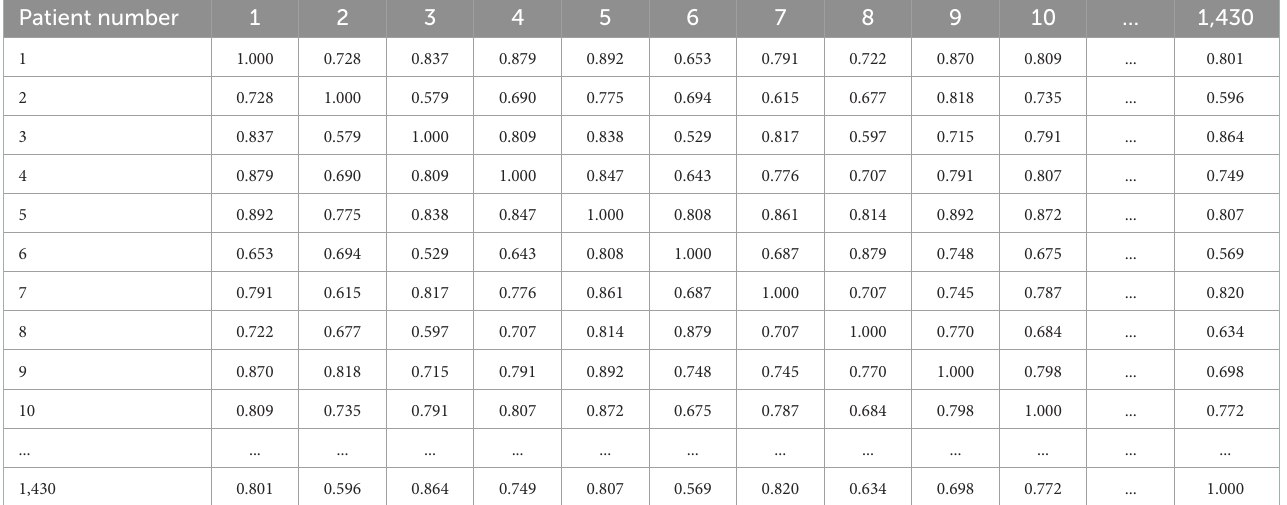
TABLE 7 The cosine similarity of the patient’s main complaint